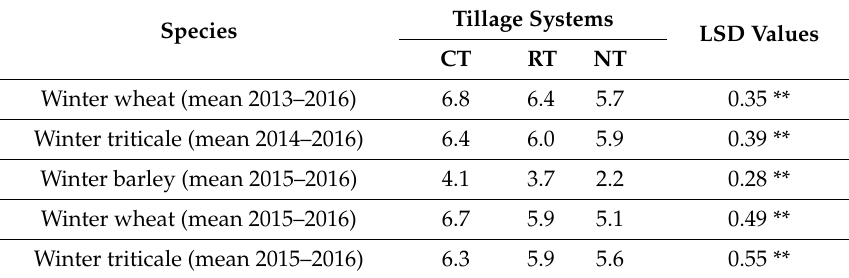
Table 6. E ff ect of soil tillage system on cereal yield (t ha − 1 ) in the crop